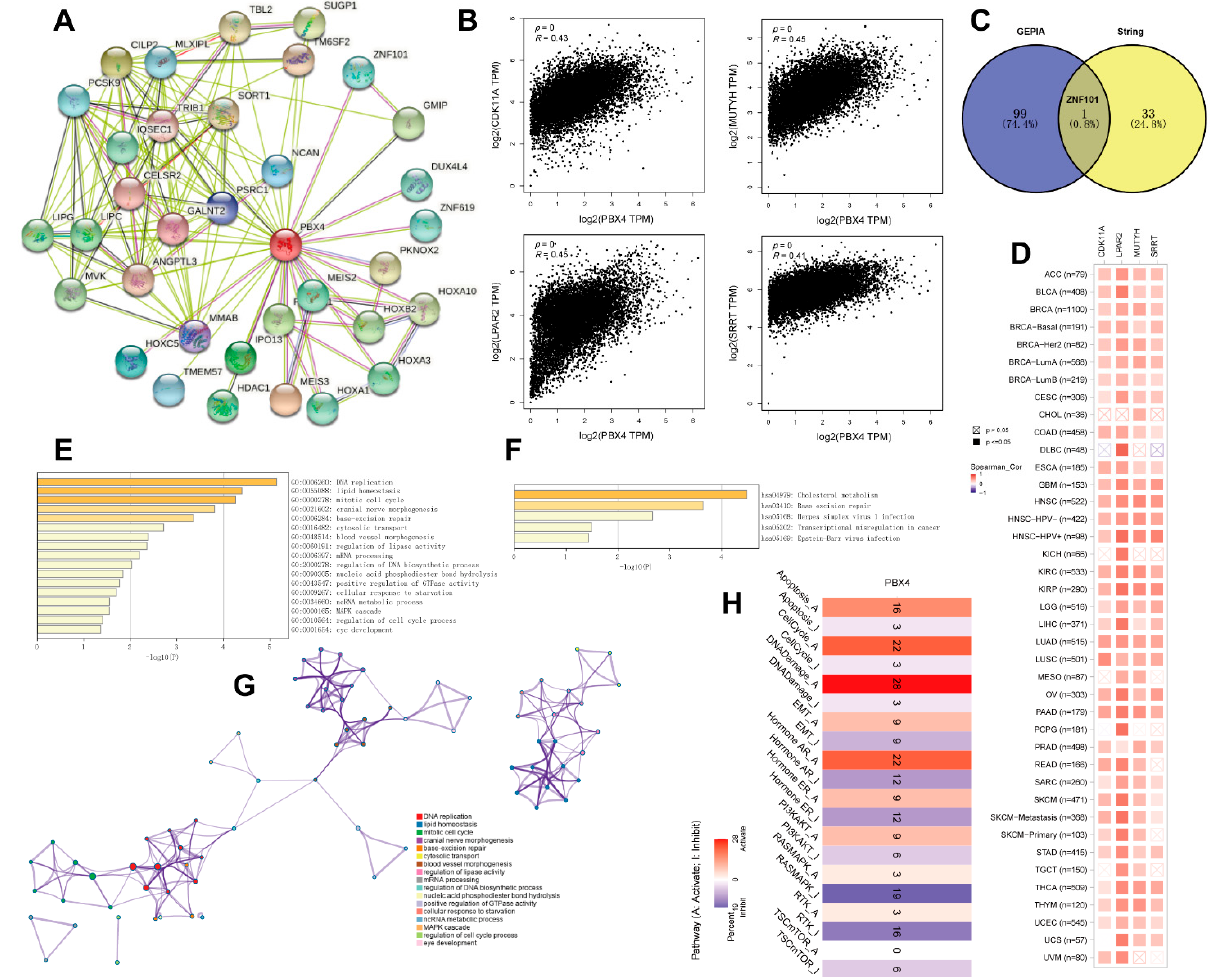
Figure 10. Functional analysis of genes and proteins relevant to PBX4. ( A ) STRING protein–protein interaction network of PBX4-binding proteins (nodes and edges represent proteins and protein– protein associations, respectively). ( B ) The top four genes (CDK11A, LPAR2, MUTYH, and SRRT) were most strongly correlated to PBX4 in TCGA database. ( C ) Intersection analysis of the PBX4- correlated genes and PBX4-binding proteins. ( D ) Heatmap of the expression correlations between PBX4 and CDK11A, LPAR2, MUTYH, and SRRT across TCGA cancers. ( E ) Biological process analysis of the PBX4-related genes (bar graph of enriched terms colored by p -values) and ( G ) the corresponding network of enriched terms (nodes of enriched terms colored by cluster ID). ( F ) KEGG pathway analysis of PBX4-related genes (bar graph of enriched terms colored by p -values). ( H ) Summary of the effect of PBX4 mRNA expression on pathway activity across TCGA cancers.